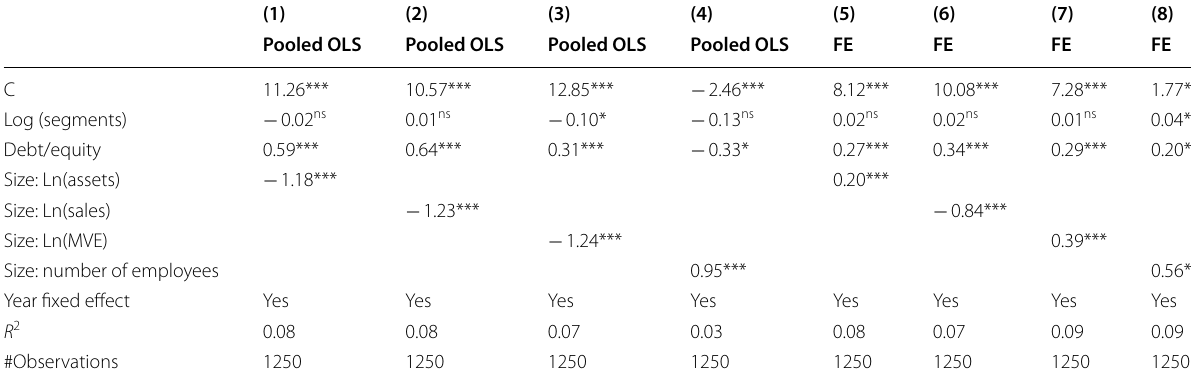
F test Chi2(3) p